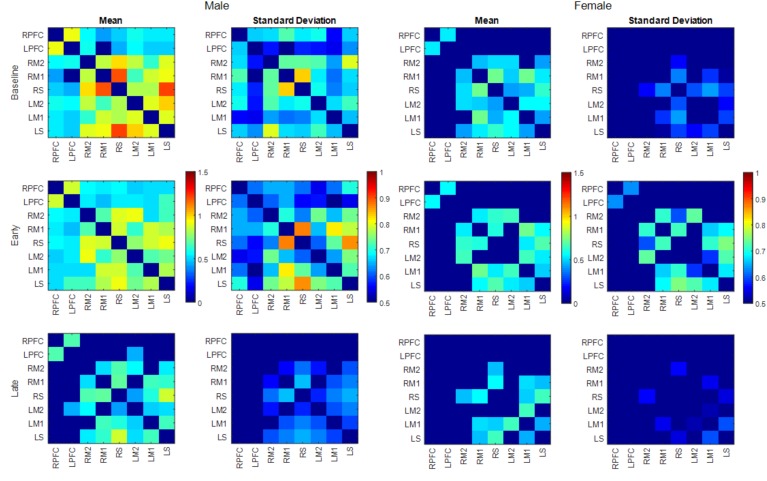
Mean and SD of connectivity matrix for each phase in males (left) and females (right). Color matrices are produced out of Fischer’s Z-score.